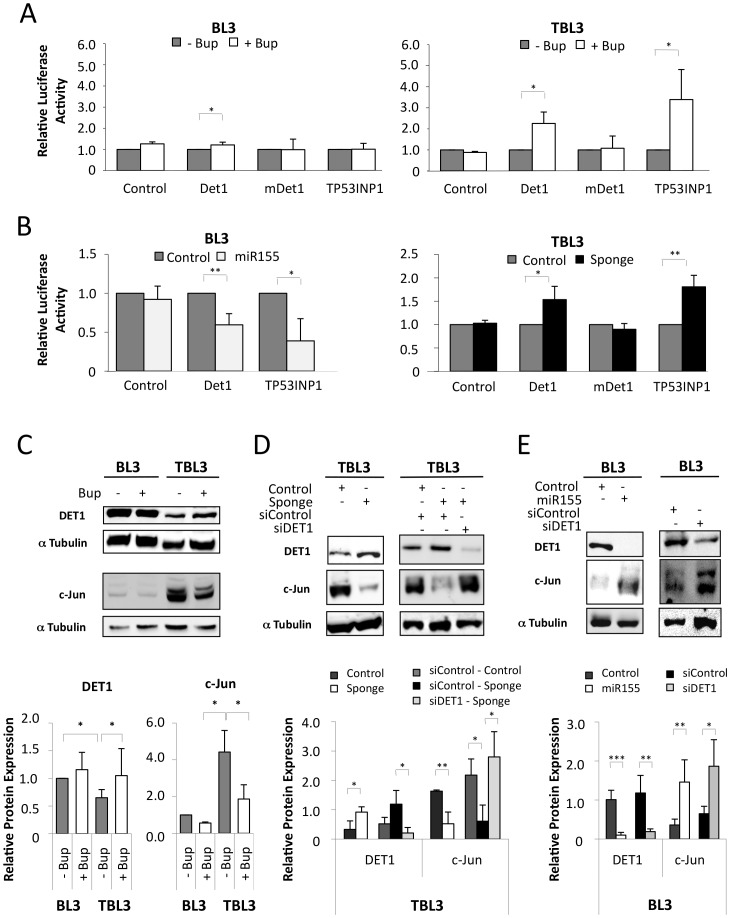
Bovine DET1 is a direct target of the miR-155 oncomiR.
(A) Luciferase reporters containing the total 3′UTR of DET1 and TP53INP1 show that Buparvaquone induced Luciferase in parasitized TBL3 cells, but not in parental BL3 cells, and Luciferase induction was lost when the miR-155 target binding site was mutated (mDet1) (average ± sd, n = 3). (B) Luciferase-3′UTR analysis demonstrated that the DET1 and TP53INP1 reporters were suppressed by miR-155 transfection in BL3 cells (left panel) and that a miR-155 Sponge inhibitor induced luciferase activity in TBL3 cells (right panel), dependent on the miR-155 target site (average ± sd, n = 3). (C) Western blot analysis of DET1 and its target protein c-Jun. TBL3 cells showed reduced DET1 protein and elevated c-Jun compared to unparasitized BL3 cells, and the levels were reversed by treatment with Buparvaquone. α Tubulin was used as a loading control. Relative quantification (lower panel) indicates the DET1/Tubulin and c-Jun/Tubulin ratios calculated with Image J software (average ± sd, n = 3). (D) Inhibition by the miR-155 Sponge in TBL3 cells caused upregulation of DET1 protein and decreased c-Jun protein. These effects were reversed by siRNA against DET1. Relative quantification (lower panel) indicates the DET1/Tubulin and c-Jun/Tubulin ratios calculated with Image J software (average ± sd, n = 3). (E) In BL3 cells, the transfection of either miR-155 or siRNA DET1 caused decreased DET1 protein and elevated c-Jun protein levels. Relative quantification (lower panel) indicates the DET1/Tubulin and c-Jun/Tubulin ratios calculated with Image J software (average ± sd, n = 3). *p<0.05, **p<0.01, ***p<0.001.